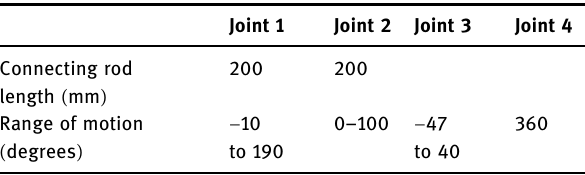
Table 1: Parameters of each joint of the